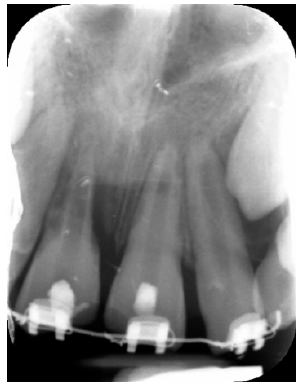
Figure 3. Periapical radiograph 3 weeks after the first endodontic approach, showing a decrease in progression of external root resorption of tooth 11.